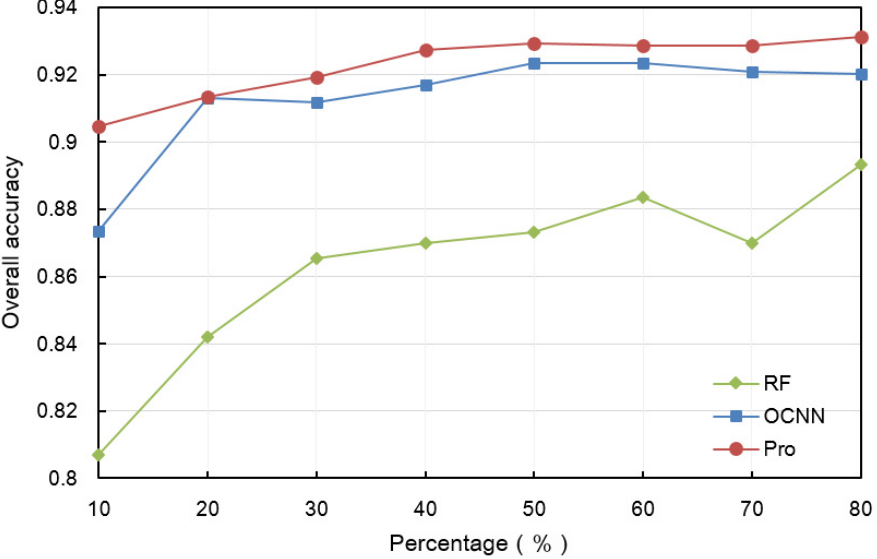
Figure 8. Effect of sample size on tea plantation extraction.